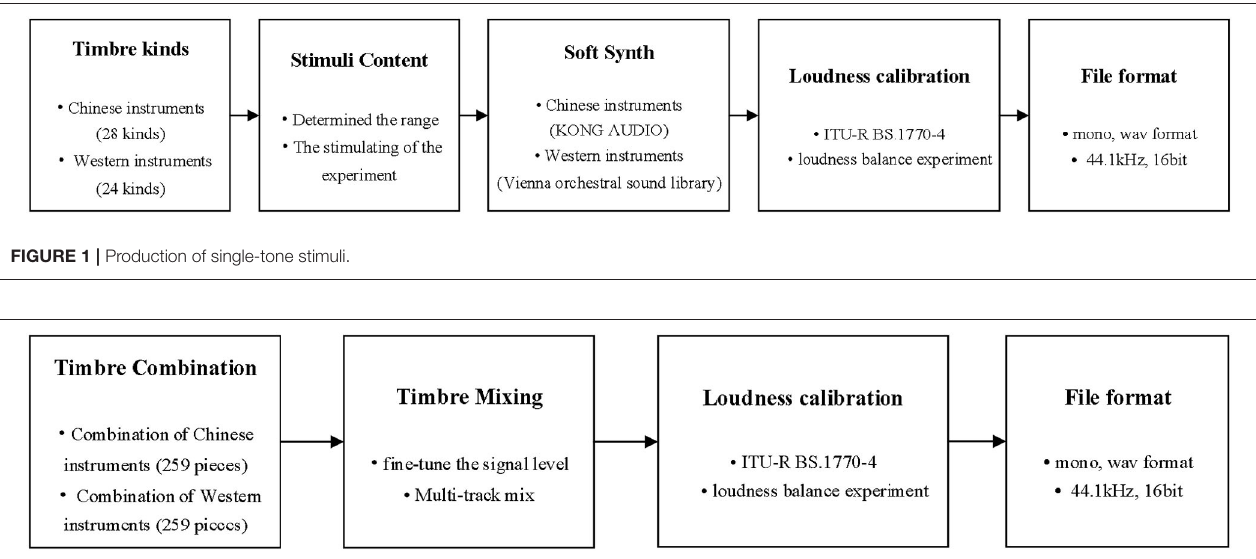
FIGURE 2 | Production of mixed timbre experimental